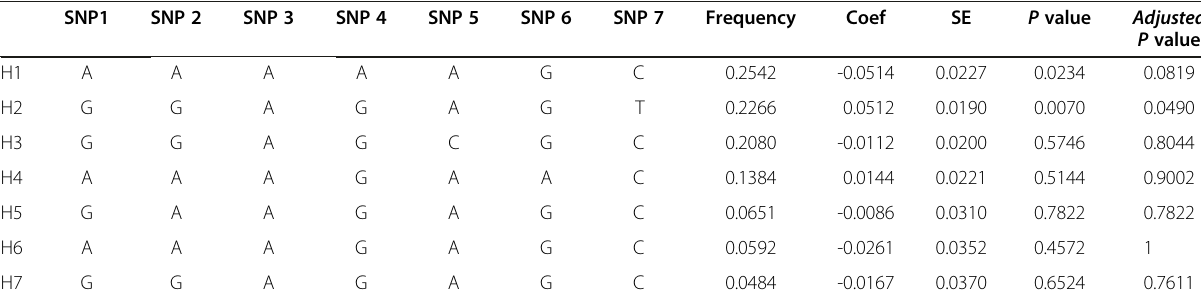
Table 3 Association of SELE locus haplotypes with MMP9 level (adjusted for age, gender, BMI, and smoking) SNP1